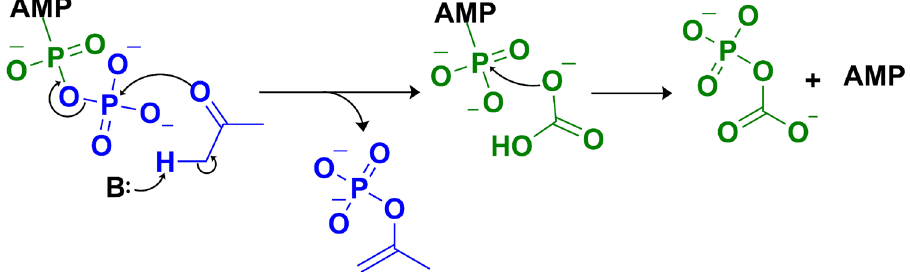
Figure 4. Phosphorylation of substrates. The phosphorylation reaction takes place in the β -subunit nucleotide-binding site. The phosphorylation of acetone starts with deprotonation of α -carbon of acetone by a yet unidentified basic residue, forming an enolate which is phosphorylated by the γ -phosphate (blue) to form phosphoenolacetone. Bicarbonate is subsequently phosphorylated by the β -phosphate (green) to form carboxyphosphate and